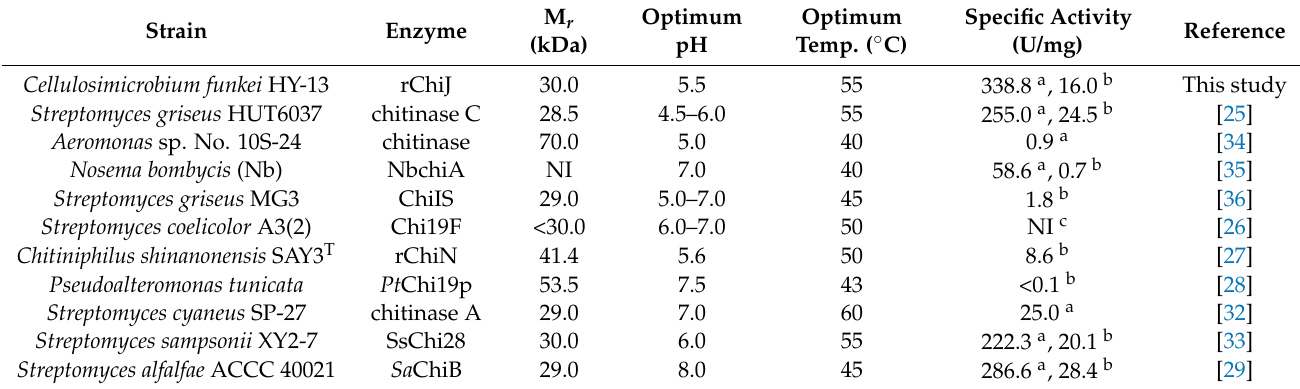
Table 1. Enzymatic characteristics of GH19 chitinases (E.C.3.2.1.14) active for chitin